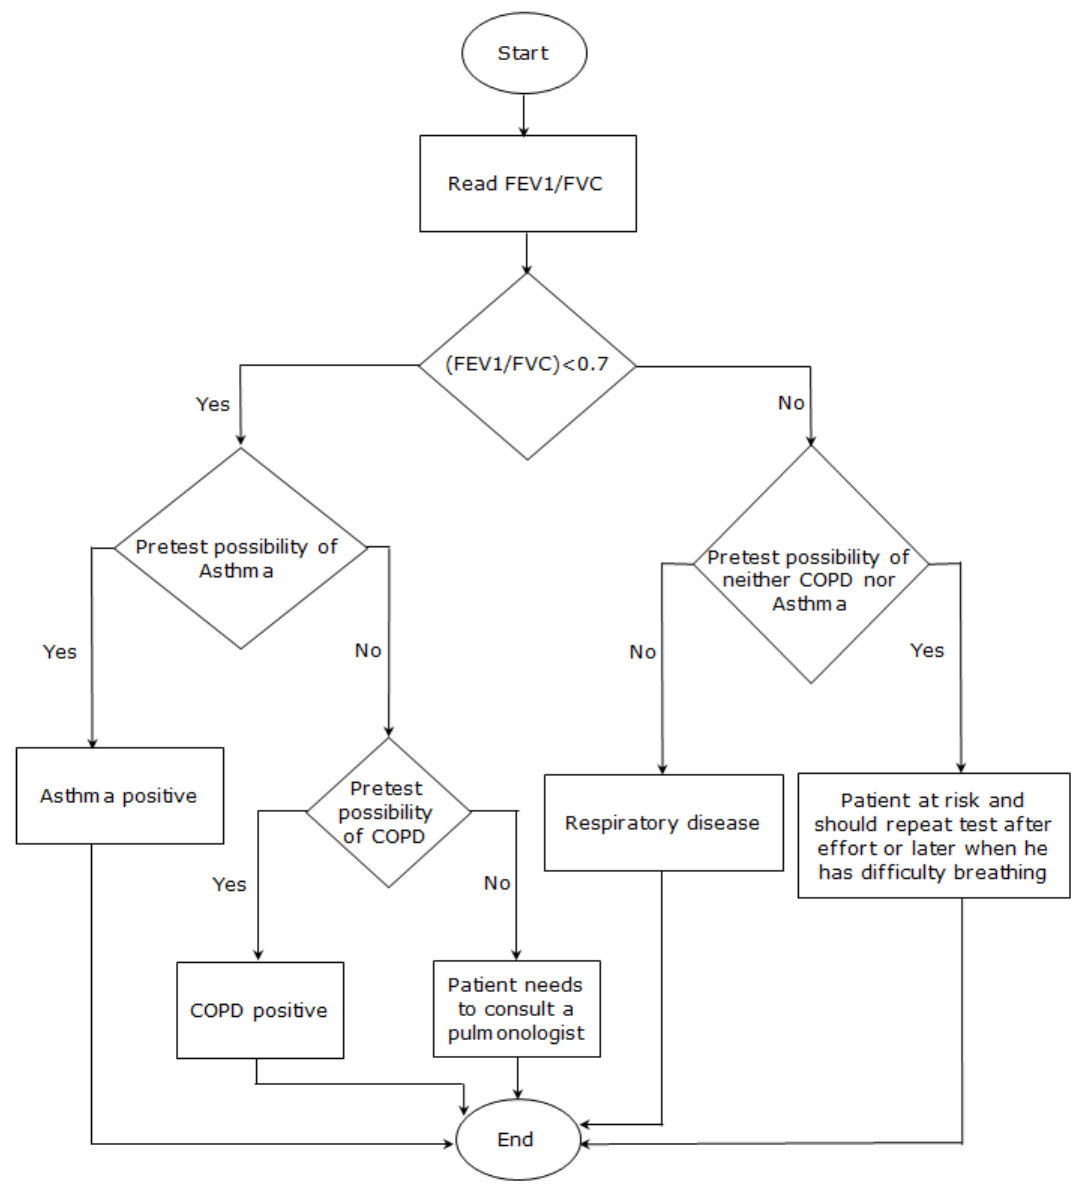
Figure 2. Diagnosis of chronic obstructive pulmonary disease (COPD) and asthma.